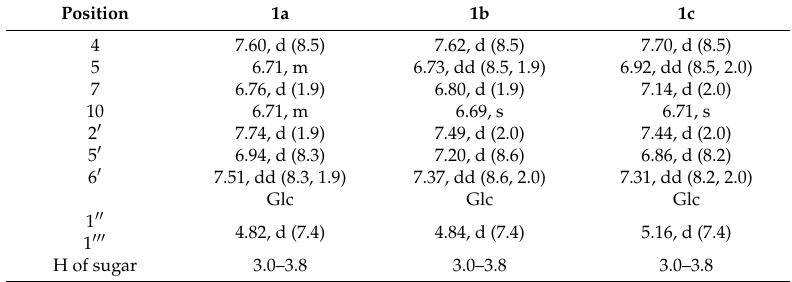
Table 1. 1 H NMR (600 MHz) spectroscopic data ( δ in ppm, J in Hz) for compounds 1a ~ 1c in DMSO- d 6 . Position